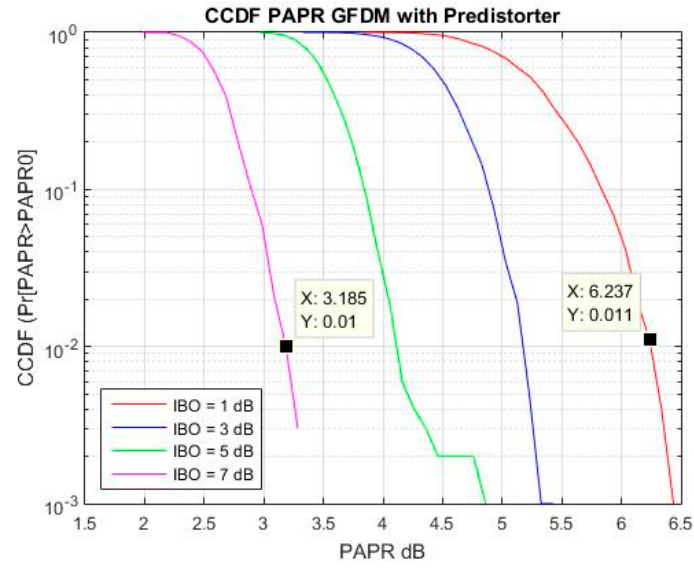
+ predistorter with IBO variations. Figure 11. Comparison of PAPR GFDM+predistorter with IBO variations. Figure 11. Comparison of PAPR GFDM